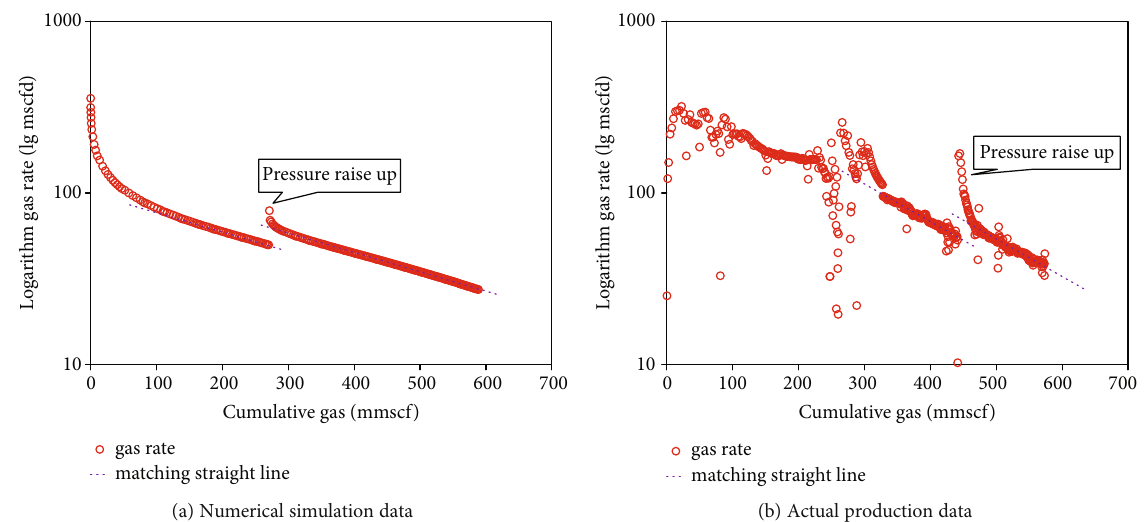
Figure 6: Production feature of fl owing pressure raising